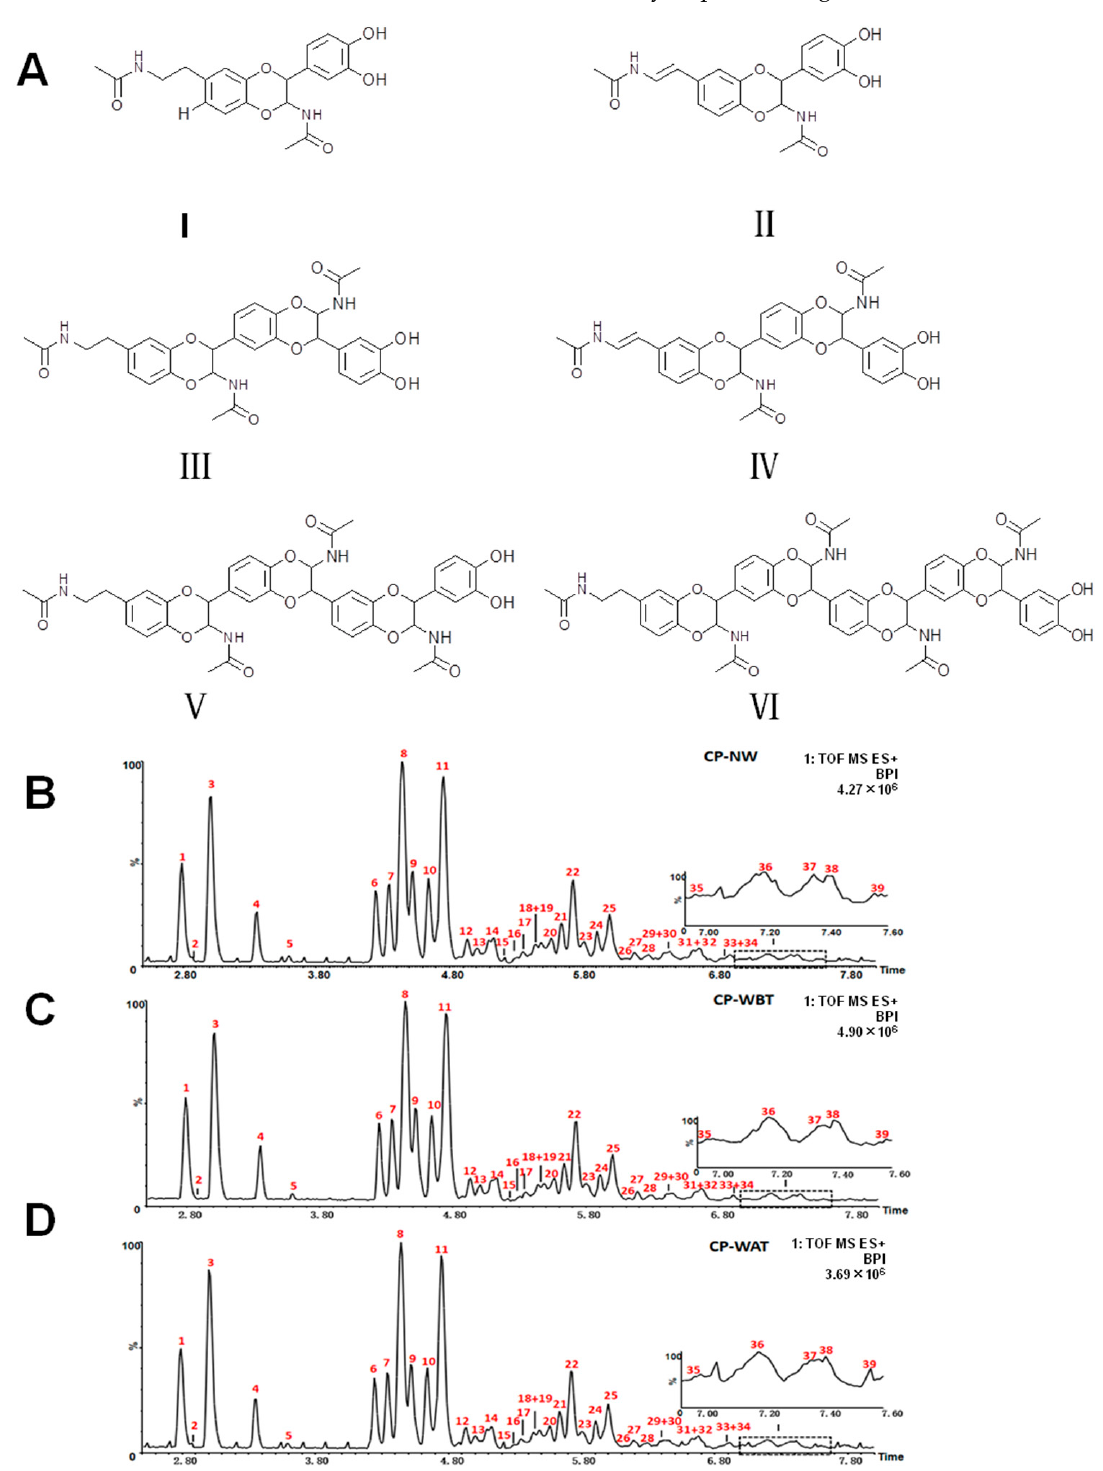
Figure 2. Chemical structures of different types of N -acetyldopamine oligomers and UPLC-QTOF-MS BPI chromatograms of three kinds of CP samples in positive ion mode. ( A ) (I) dimers, (II) side-chain isomer of dimers, (III) trimers, (IV) side-chain isomer of trimers, (V) tetramers, (VI) pentamers; ( B ) CP-NW; ( C ) CP-WBT; ( D )